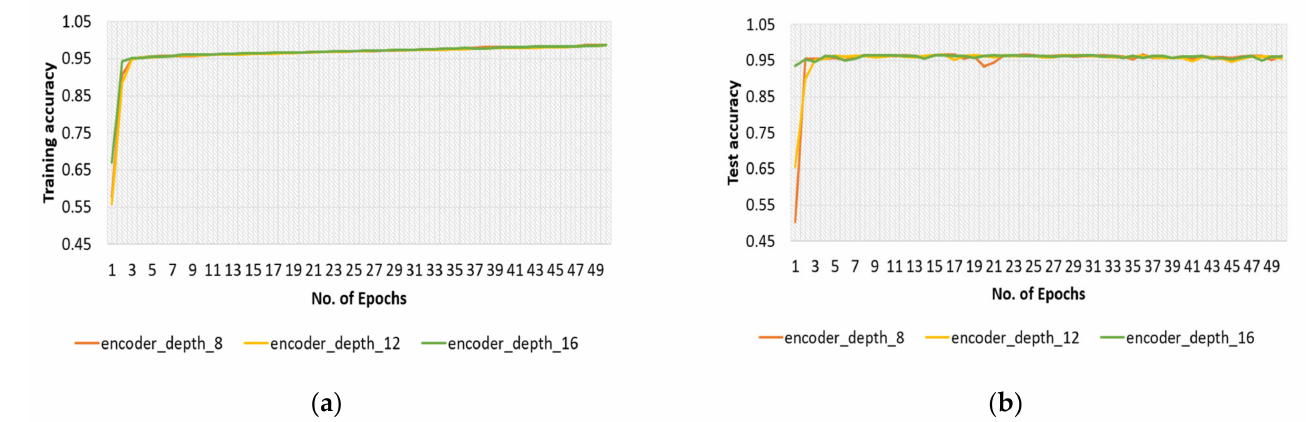
Figure 11. ( a ) Training curves and ( b ) test curves of the proposed model obtained with original dataset and encoder depths of 8, 12, and 16.